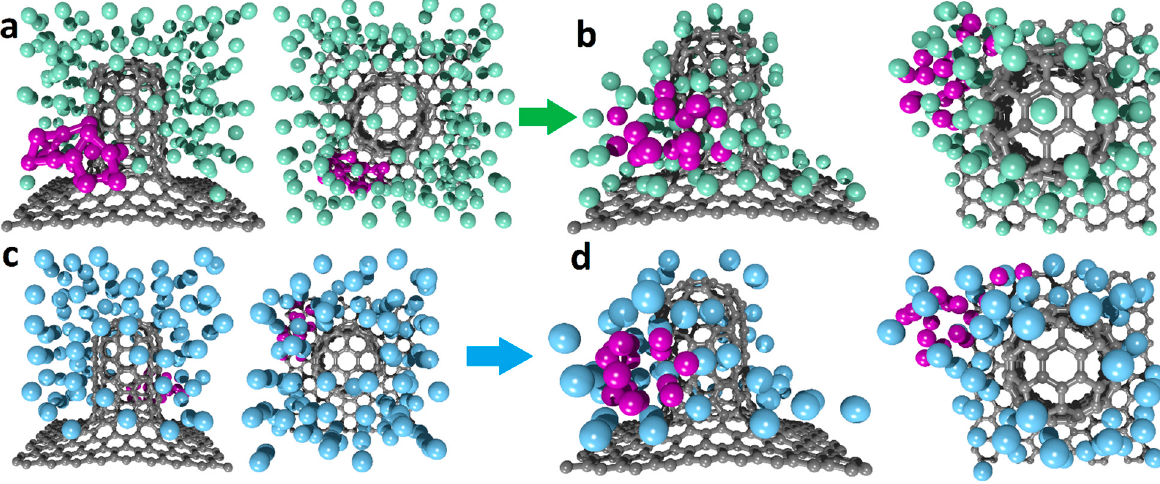
Figure 4. Composite with a silicon cluster, showing the Li or Na filling process ( a , b ) and the result of atomic structure relaxation ( c , d ).